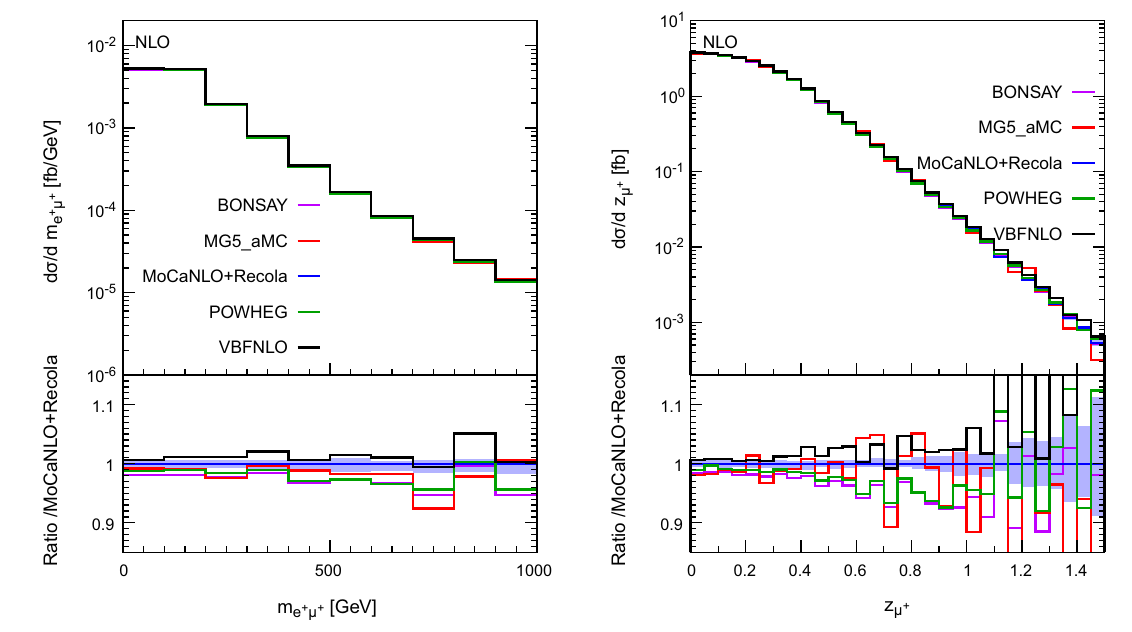
Fig. 12 Differential distributions in the invariant mass of the two charged leptons (left) and Zeppenfeld variable for the muon (right) at NLO accuracy i.e. at order O (α s α 6 ) . The description of the differ- ent programs used can be found in Sect. 3.2. The upper plots provide the absolute value for each prediction while the lower plots present all